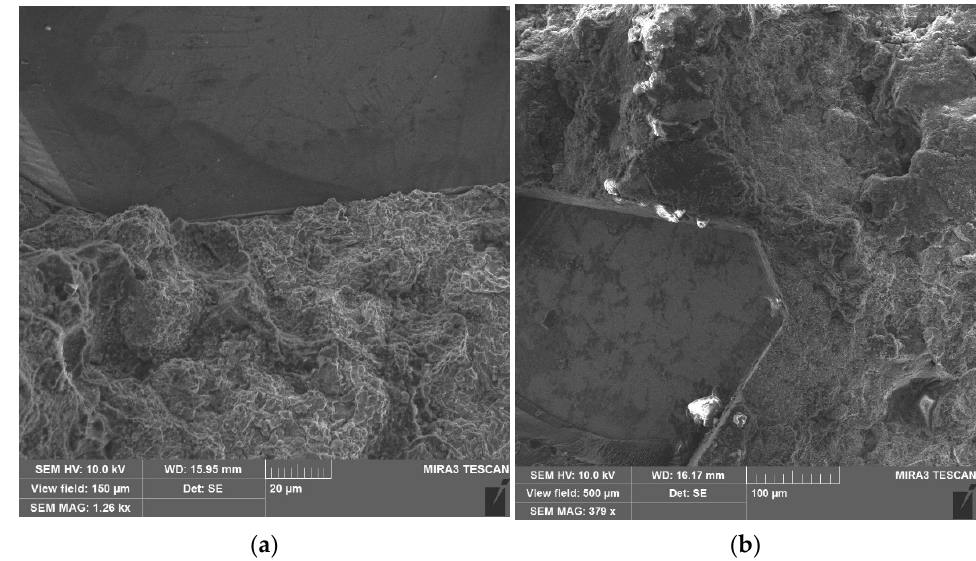
Figure 4. Details of the fracture surface of diamond composite sample 1 at temperature +20 °C, adjacent to the diamond–matrix interface ( a ) 20 μ m scale; ( b ) 100 μ m scale.